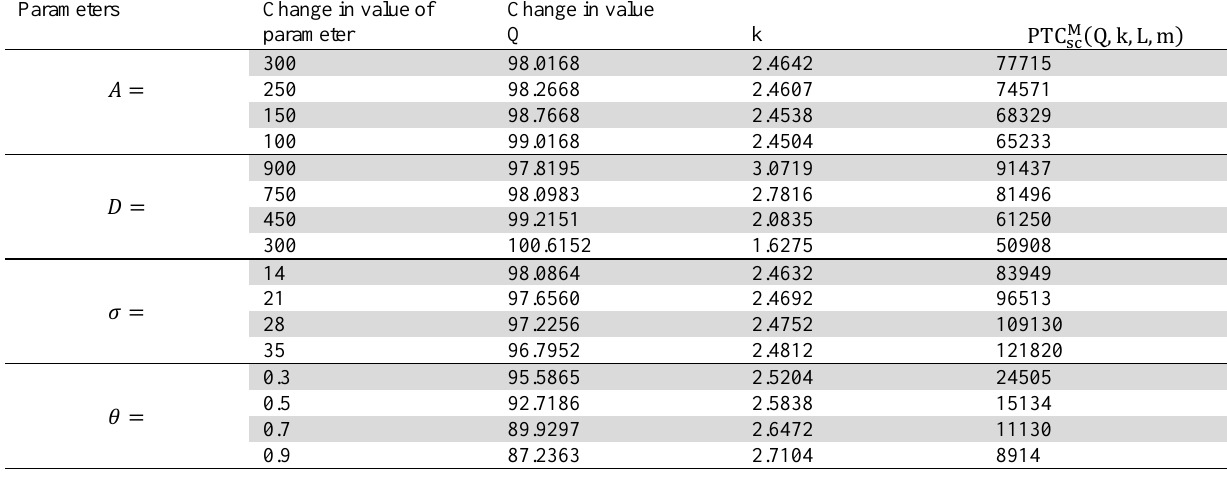
Sensitivity analysis for numerical example 2